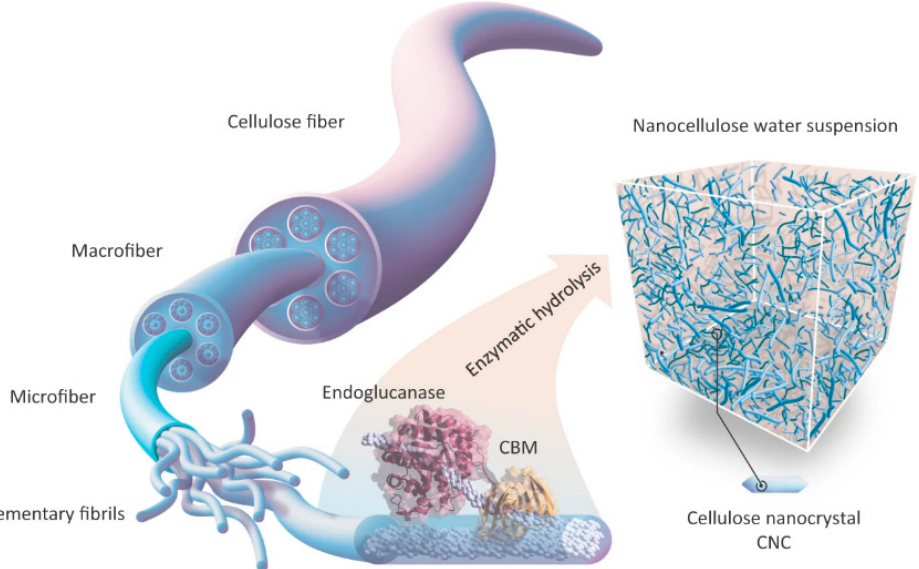
Figure 4. Illustration of formation of CNC via enzyme hydrolysis. Reproduced with permission from [73].